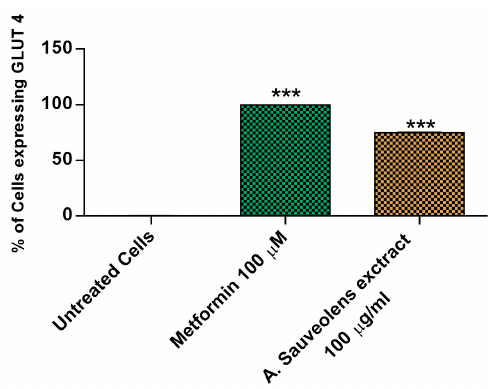
Fig. 7. GLUT Vs 3T3L1. The percentage of cells expressing GLUT4 comparison with Untreated, Metformin and A. suaveolens extract.